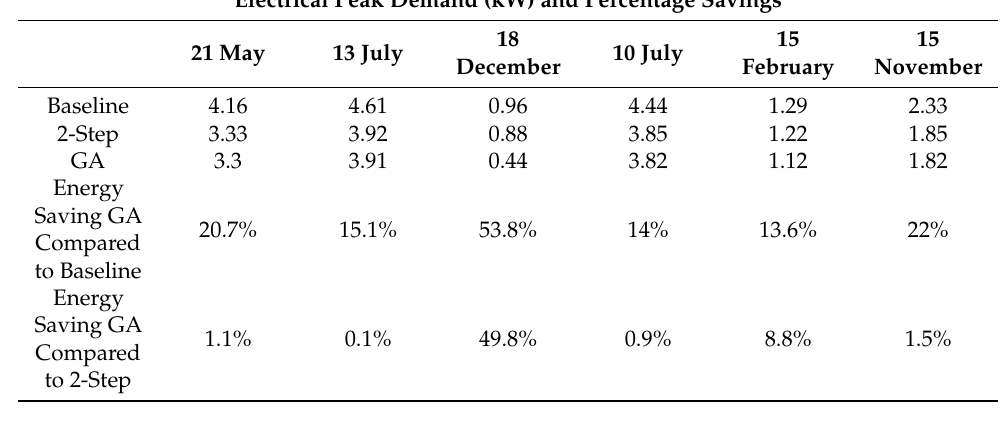
Table 9. Electrical peak demand for baseline windows and optimized STIS–smart windows applied to a house in Phoenix, AZ, USA—for six representative days using two control strategies.